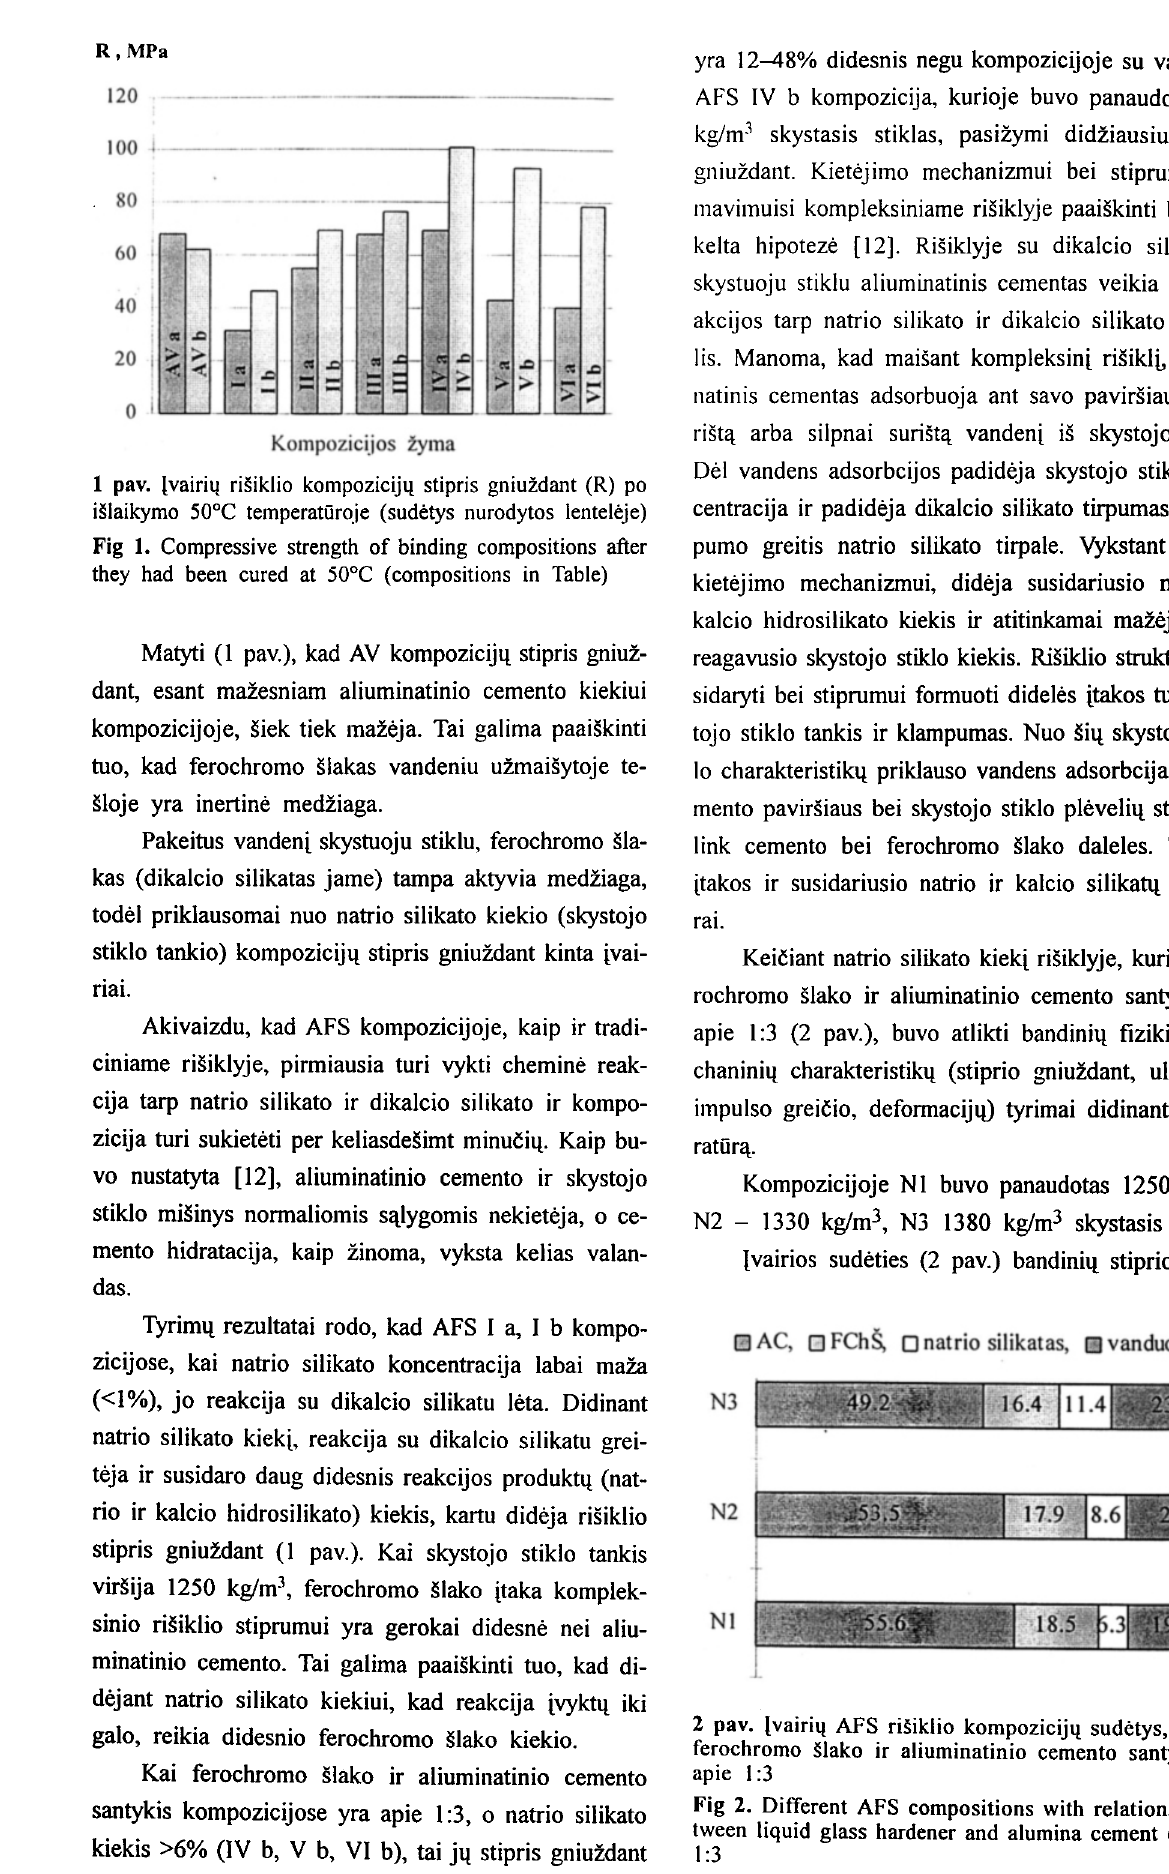
Fig 2. Different AFS compositions with relationship be tween liquid glass hardener and alumina cement of about